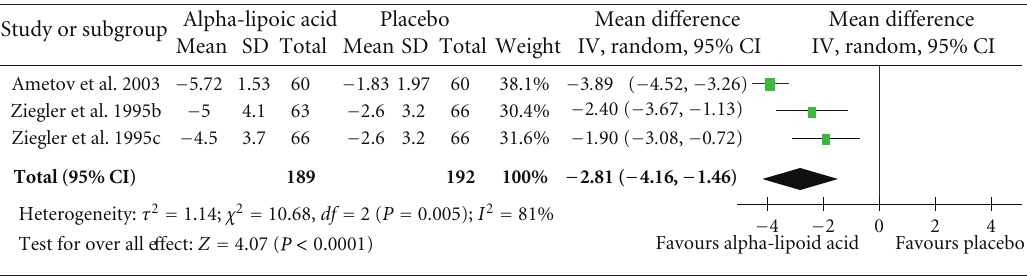
Table 5: Standardized mean di ff erences for the administration of intravenously administered alpha-lipoic acid versus placebo in the treatment of neuropathic pain. Diamond denotes pooled estimate of overall e ff ect. Weighing of individual studies is based on the inverse variance method. For subgroups, see Table 3.